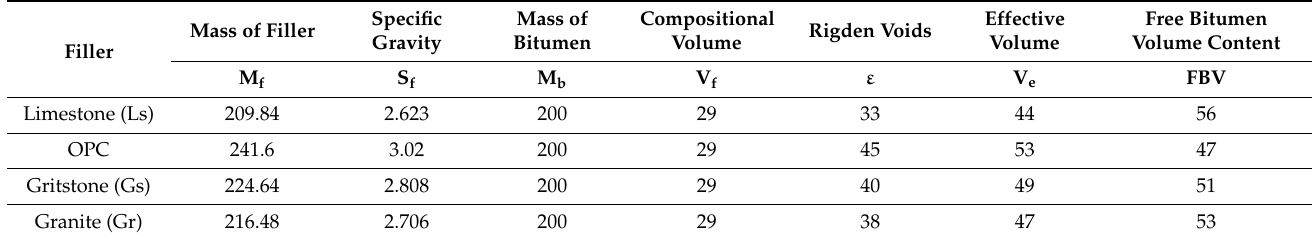
Table 3. Compositional and effective volume calculation.